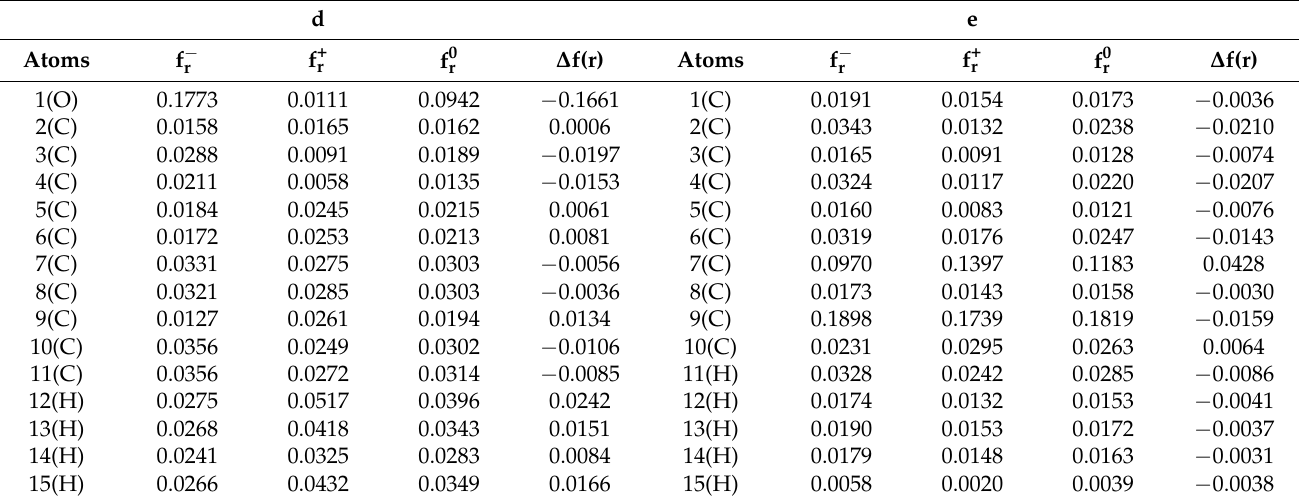
Table 4. The condensed Fukui functions for the binary mixtures 1,8-cineole–water (d) and β -pinene– water